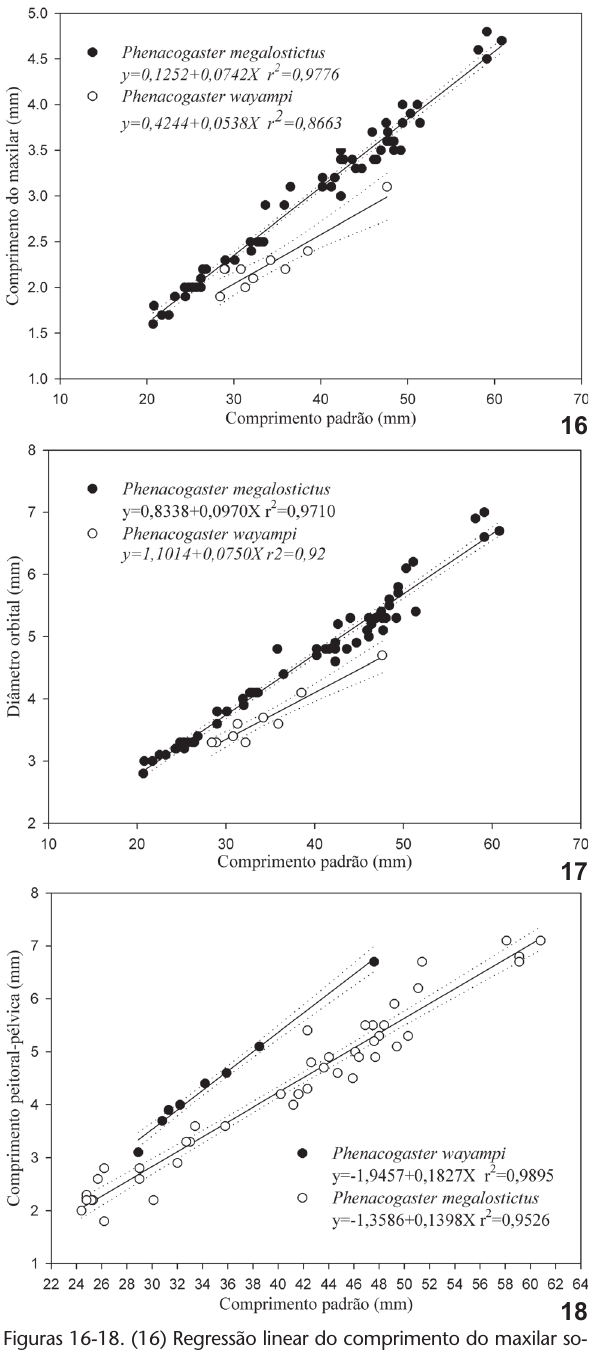
Figuras 16-18. (16) Regressão linear do comprimento do maxilar so- bre o comprimento padrão em P. megalostictus e P. wayampi ; (17) re- gressão linear do diâmetro orbital sobre o comprimento padrão em